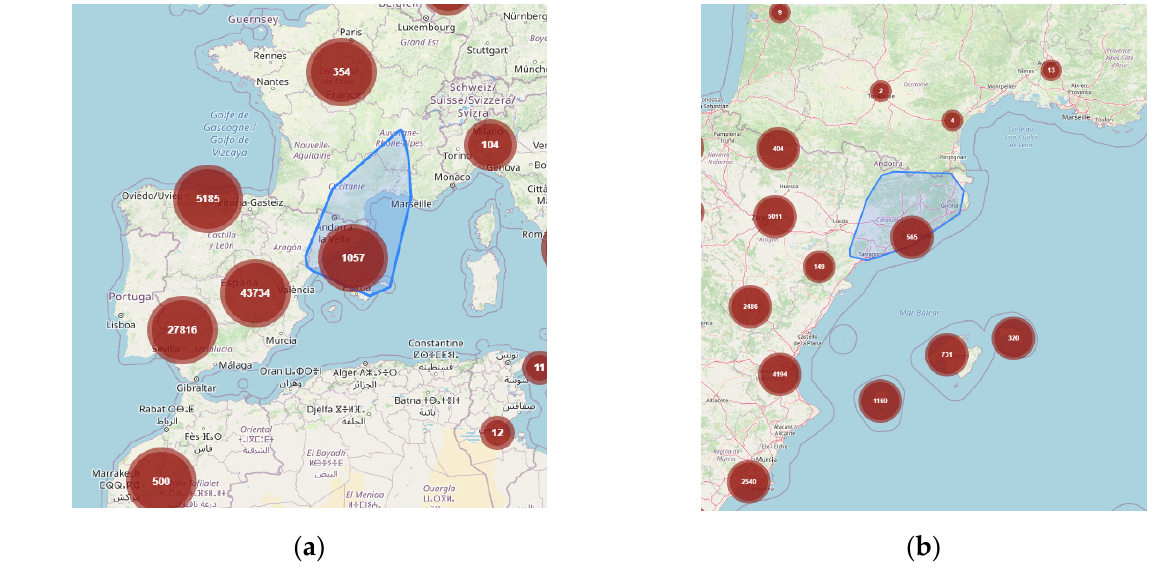
Figure 5. Areas covered by a single cluster, where: ( a ) an example of a cluster of 1057 objects; ( b ) an example of a cluster of 565 objects.